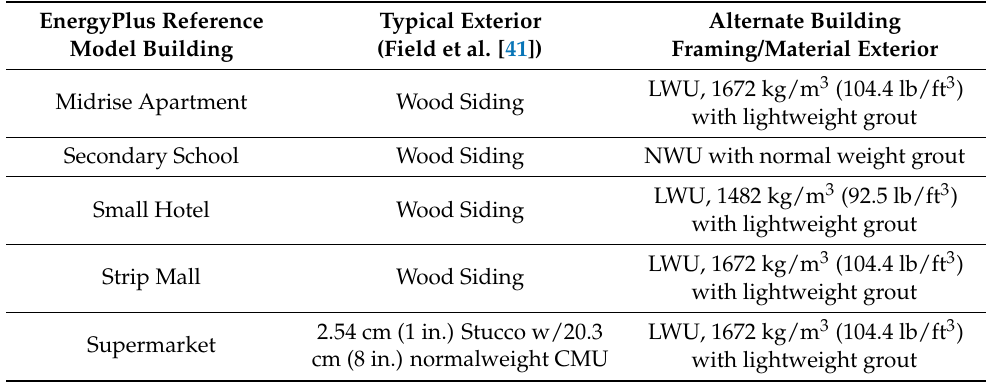
Table 6. Typicalandalternatebuildingmaterialsutilizedforreferencemodelsinbuildingenergysimulations. EnergyPlus